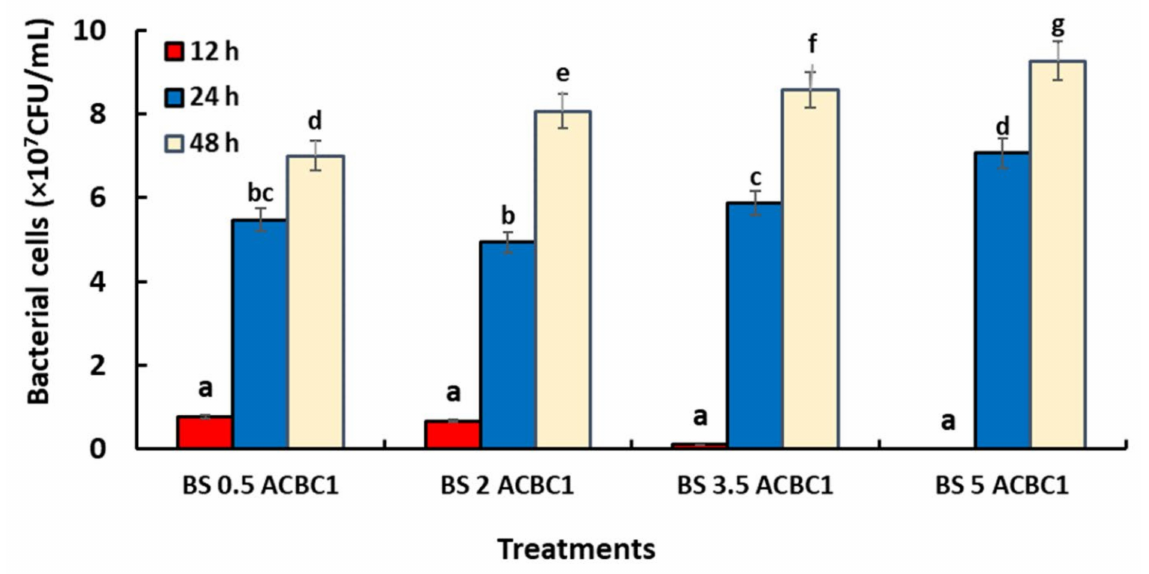
Figure 1. Effect of different concentrations of SBC solution (%), and duration (h) on the bacterial cell growth of ACBC1 ( Alcaligenes faecalis ) grown on PDB medium for 48 h at 25 ◦ C under agitation. Treatments with the same letters (a–g) are not significantly different according to the LSD ( p < 0.05) in descending order of data in Figure